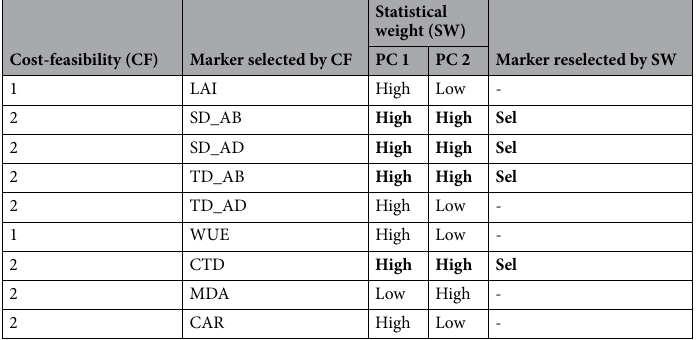
Table 5. Selection of phenotyping markers according to their CF and SW. Markers with CF of 1 or 2 and High SW in both autovectors were selected. Significant values are in